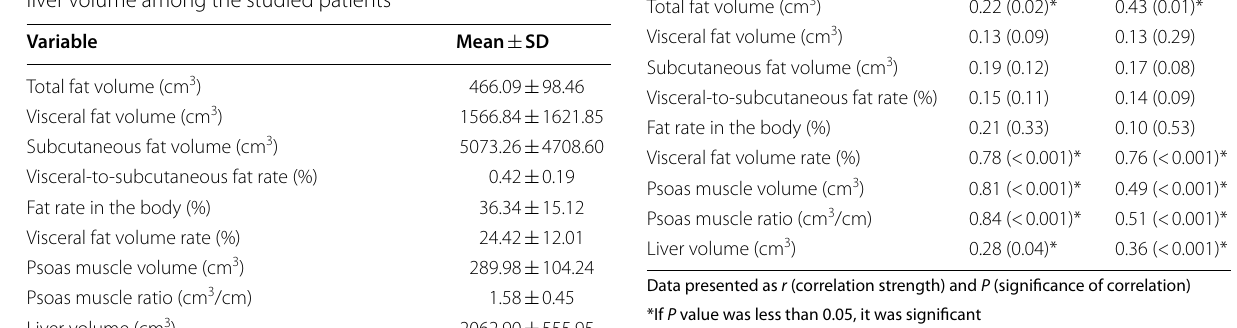
Table 4 Visceral and subcutaneous fat, psoas muscle mass, and